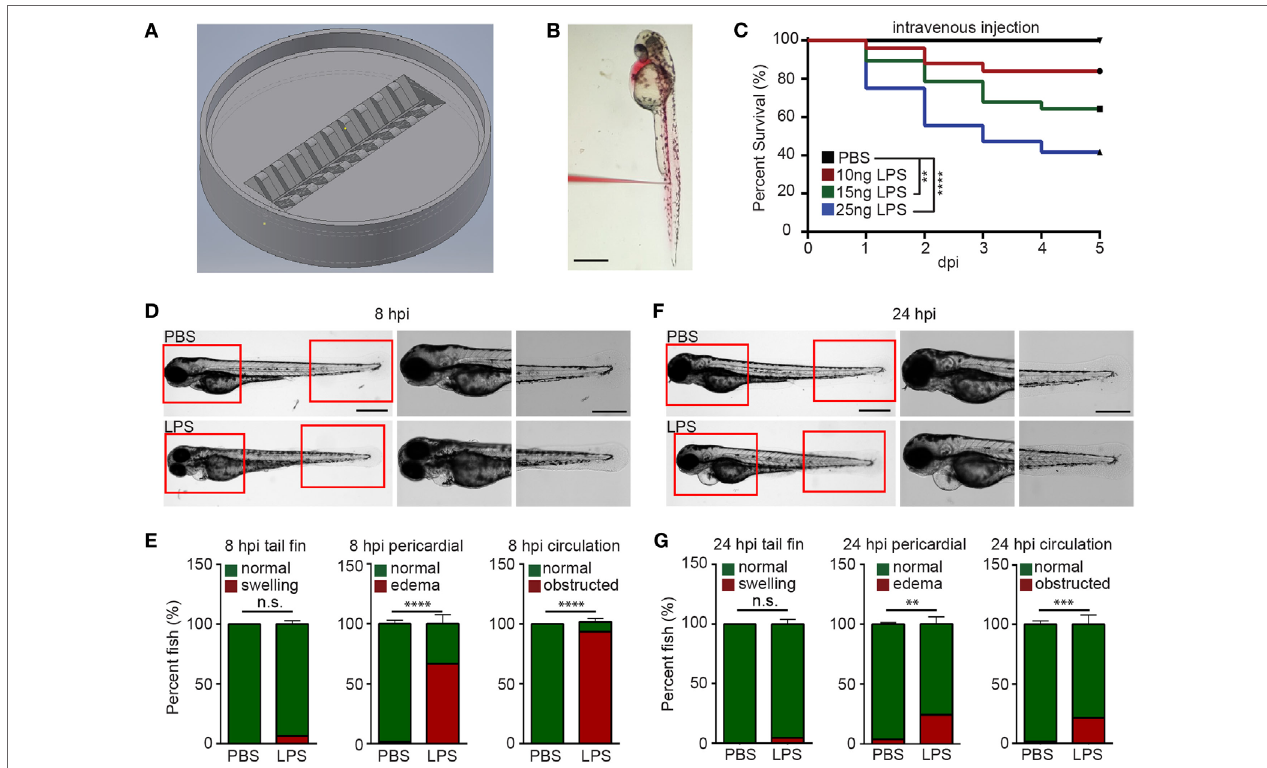
FigUre 1 | Zebra fish intravenous (IV) injection plate design and IV lipopolysaccharide (LPS) injection. (a) Illustration of the zebra fish IV injection plate. (B) A representative image of zebra fish larvae at 3 days post fertilization injected with PBS containing 1% Phenol Red. Scale bar: 500 µm. (c) Survival curve of zebra fish after PBS or 10, 15, and 25 ng LPS IV injection. One representative experiment of three independent biological repeats ( n > 20 each group) is shown. ** p < 0.01, **** p < 0.0001, Gehan–Breslow–Wilcoxon test. (D) Representative images of zebra fish larvae injected with PBS or LPS at 8 hours post injection (hpi). Scale bar: 500 µm. Boxed regions of the pericardium and tail fin are enlarged. Scale bar: 200 µm. Images representative of three independent experiments are shown ( n = 20). (e) Percentage of fish with tail fin edema, pericardial edema, and circulation obstruction in PBS- or LPS-injected larvae at 8 hpi. Results are presented as mean ± SD ( n = 3 independent experiments with over 20 larvae each/experiment). *** p < 0.001, **** p < 0.0001, Mann–Whitney test. (F,g) Representative images and quantification of inflammatory phenotypes in LPS- or PBS-injected larvae as (D,e) at 24